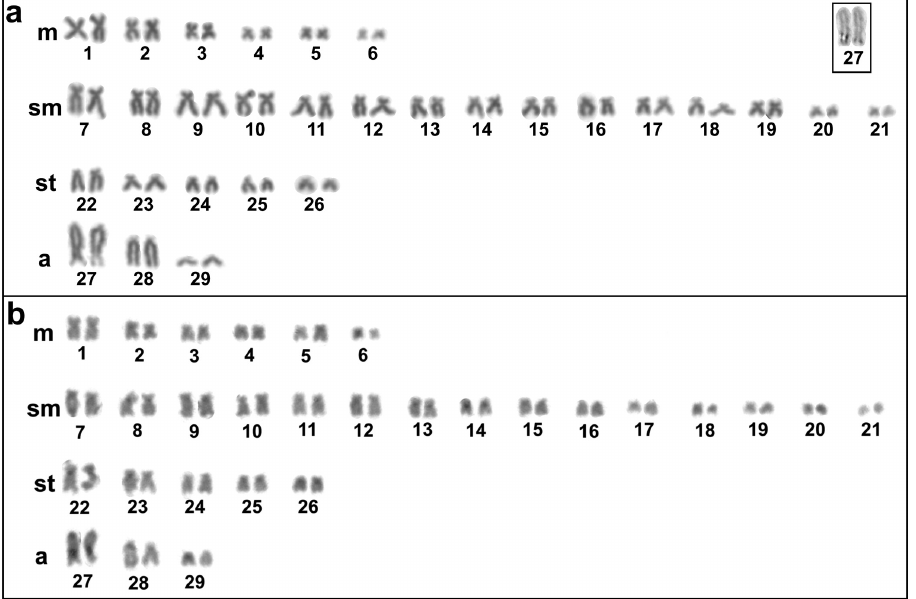
Figure 4. Karyotypes stained with Giemsa ( a ) and C-banding ( b ) of Farlowella amazonum from Dourado stream. Box: pair 27, bearing the